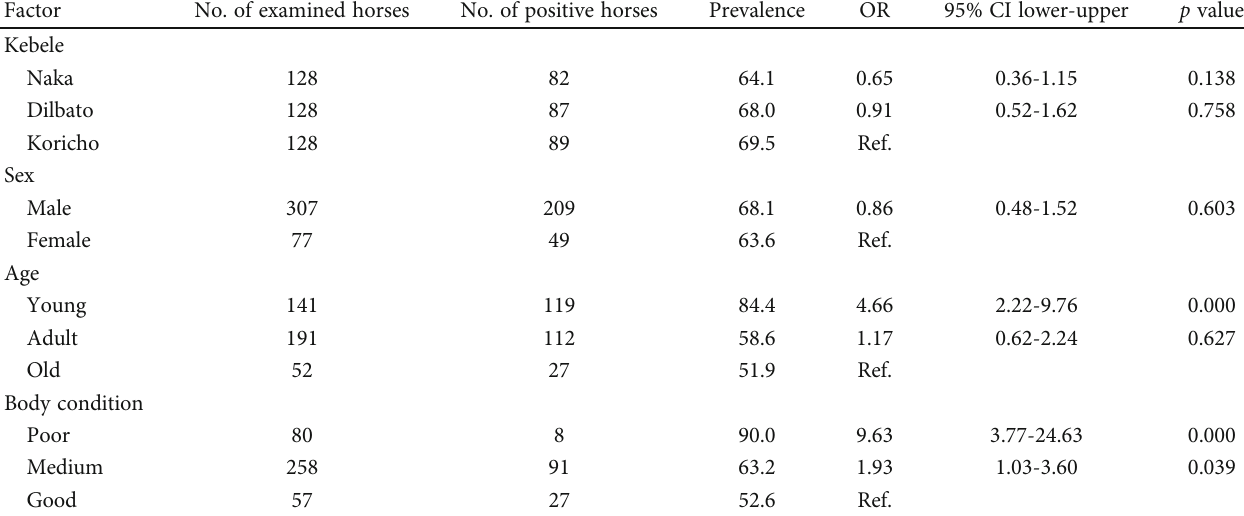
Table 3: Risk linked potential risk factors associated to Strongylosis.